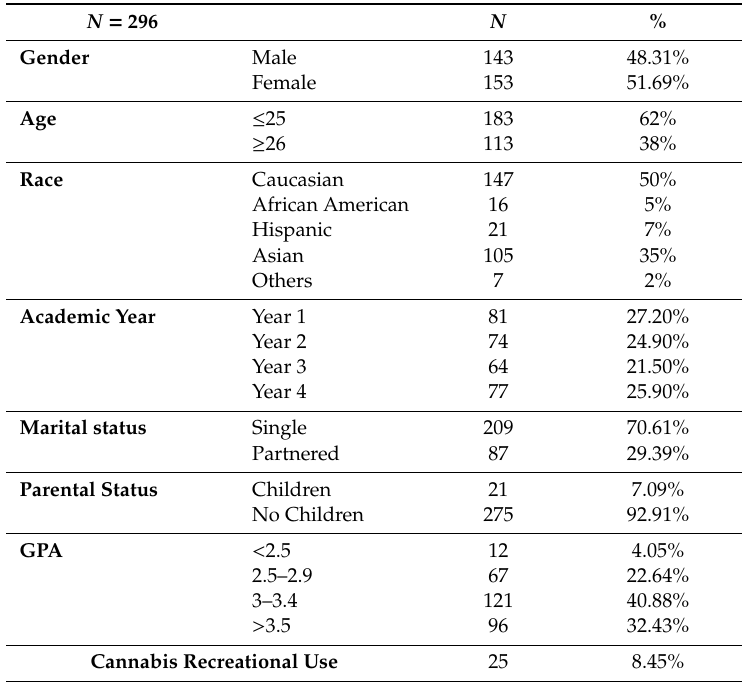
Table 1. Demographic characteristics, grade point average (GPA), and prevalence of past month cannabis use of the sampled population.